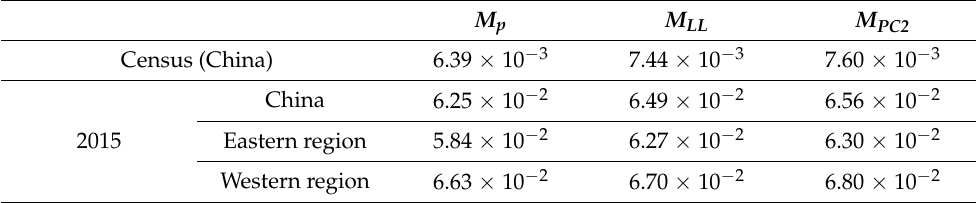
Table 3. RMSE of